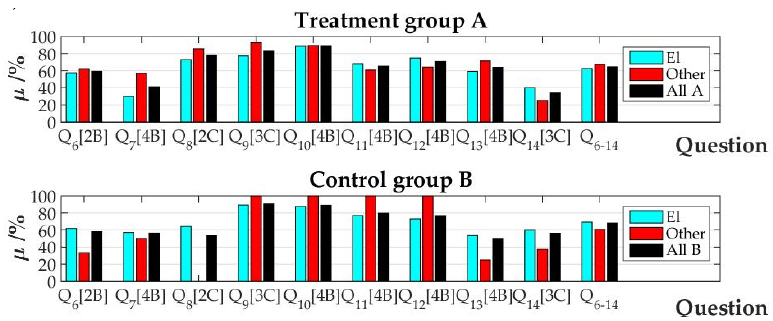
Figure 8. Final test results by study tracks for treatment group A and control group